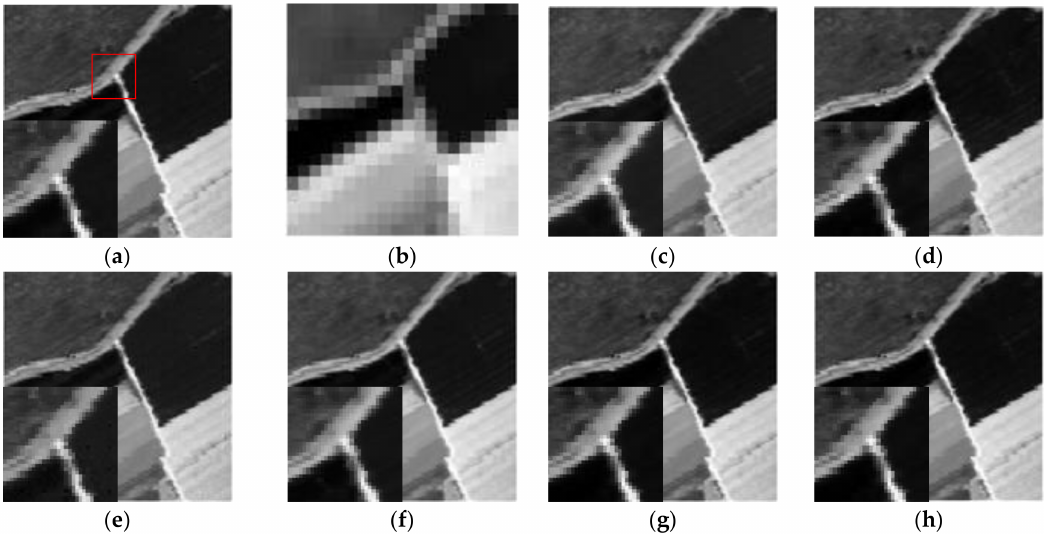
Figure 10. Details of original and resolution enhanced Salinas HSS images at a wavelength of 1541 nm: ( a ) reference; ( b ) input; ( c ) MAP; ( d ) CNMF; ( e ) Bayesian; ( f ) NSSR; ( g ) LASUF; ( h )